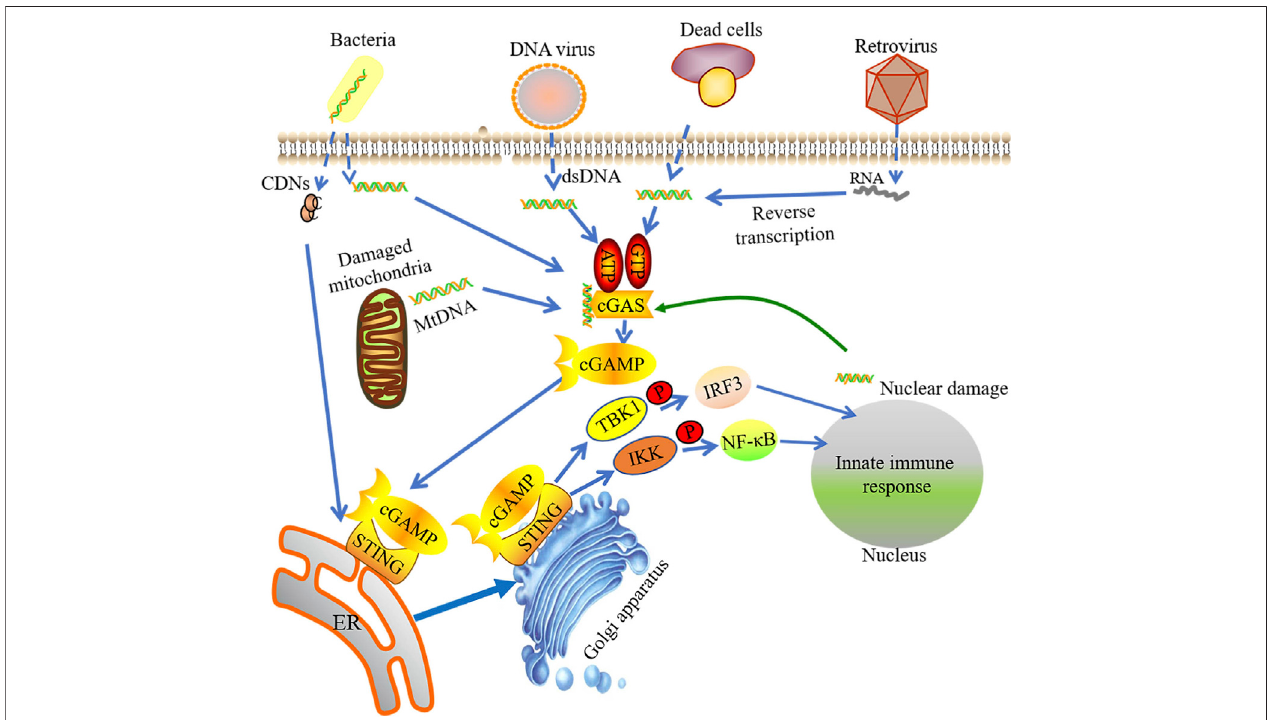
FIGURE 1 | The activation of cGAS-STING signaling pathway. Foreign DNA and RNA in cytoplasm could be sensed by cGAS, which sub-sequently facilitates the synthesisofcyclicGMP-AMP(cGAMP) bybinding withGTPand ATP.Theintegration ofcGAMPandSTING induces STINGactivation. STINGisthenswitched fromthe endoplasmicreticulum(ER)toperinuclearendosomesassistedbytheGolgiapparatus.STINGsignalingcansenseandresponsetoforeignDNAandRNAincytoplasm. The STIGN-TBK1 compound triggers innate immune response via phosphorylating IRF3 or